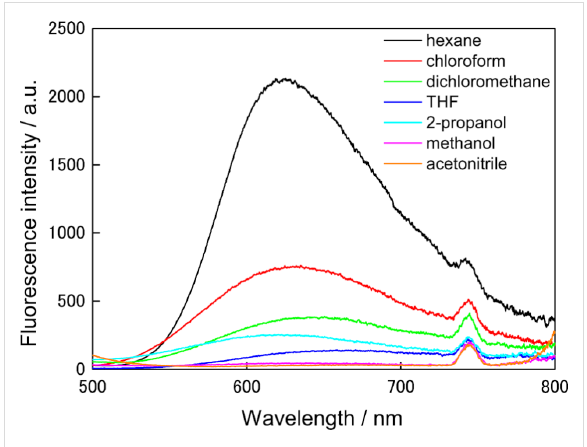
Figure 4: Fluorescent spectra of 1o in several solvents ( λ ex = 370 nm). Hexane (black line), chloroform (red line), dichloromethane (green line), THF (blue line), 2-propanol (pale blue line), methanol (pink line), acetonitrile (orange line). The absorption at the excited wavelength